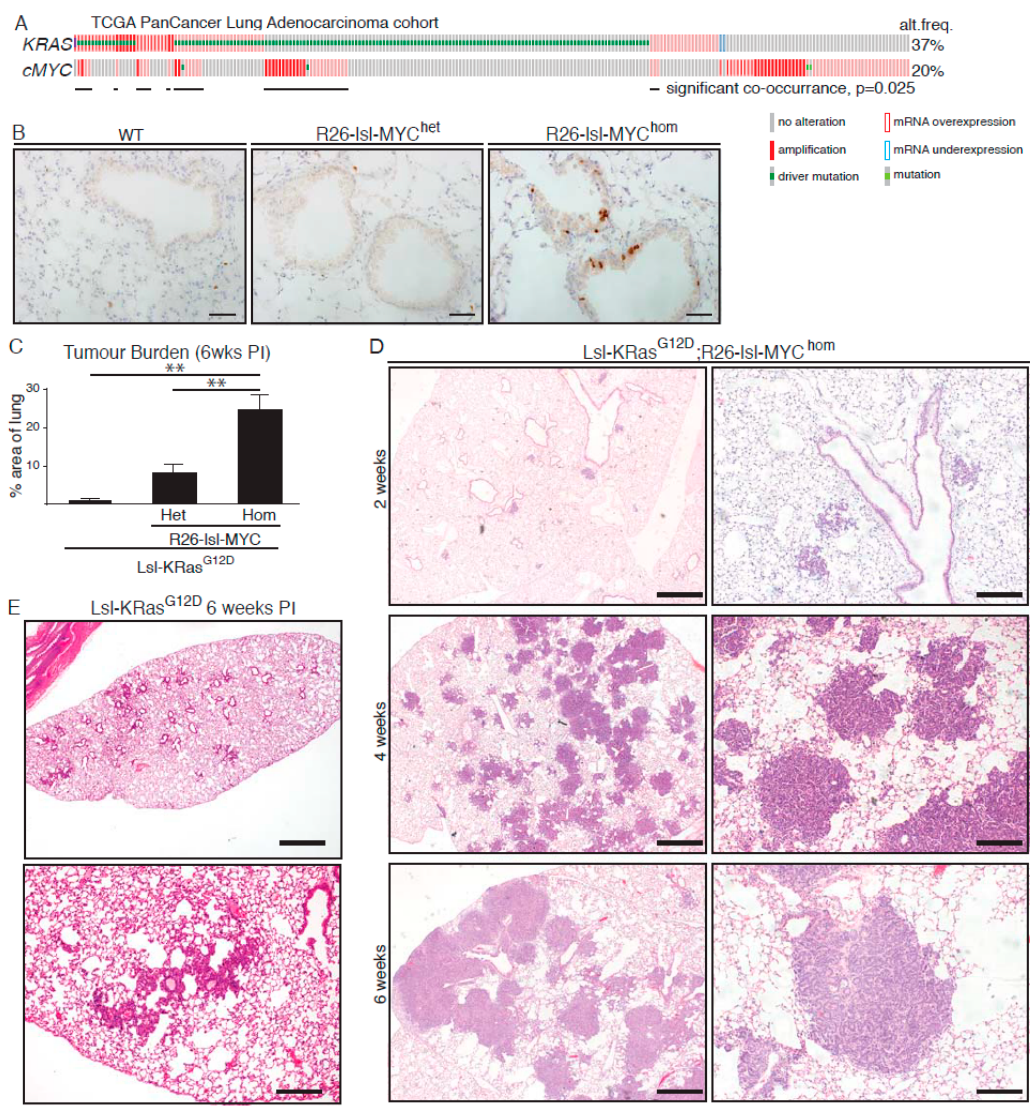
Figure 1. MYC accelerates KRas G12D -driven lung adenocarcinoma (LuAd) development. ( A ) Frequency of mutation, copy number, and mRNA expression alteration of KRAS and cMYC in the TCGA pan cancer lung adenocarcinoma cohort, accessed through cBioportal. For mRNA analysis, Z score threshold was set to 1.5. Horizontal black lines indicate cases with alteration of both KRAS and MYC. ( B ) Ectopic proliferation induced by CRE-dependent activation of Rosa26-lsl-MYC in airway epithelium evidenced by BrdU incorporation. Images are representative of at least 4 mice / genotype. Scale bar = 40 µ m. ( C ) Overall tumour burden, defined as the percent of lung area occupied by tumour tissue, in mice bearing 1 ( N = 9) or 2 ( N = 11) R26-lsl-MYC combined with lsl-KRas G12D , compared with lsl-KRas G12D alone ( N = 6), measured 6 weeks post induction (PI). Mean ± SEM shown. ** denotes p < 0.01 ( t -Test). ( D ) Adult mice (8–10weeks old) bearing the indicated conditional alleles were administered 1 × 10 7 pfu Adeno-CRE by intranasal installation and harvested at the indicated times PI. Micrographs show representative Hematoxylin and Eosin (H&E)-stained lung tissue. Scale bars = 1mm (left panels) and 200 μ m (right panels). ( E ) Age-matched lsl-KRas G12D mice were induced with the same pfu Adeno-CRE as (D) and tumour burden examined after 6 weeks. Scale bars = 1mm (top panel) and 200 μ m (bottom panel). Table 1. Specific genes upregulated in pErk High KM tumour regions. Genes were selected based on evidence of overexpression and/or amplification in human non-small cell lung cancer (NSCLC). Range of RNA-SEQ read count values, normalised for total reads per sample, for the indicated genes. FC = fold change. FDR = false discovery rate. Amp = Amplified. OverEx = Overexpressed. For “Amplified in human NSCLC”: Y = yes (1–5%) with >5% and <1% where noted; N = No; SCC = squamous cell carcinoma where noted, otherwise adenocarcinoma or unclassified. For “Overexpressed in human NSCLC”: Y = Yes; N = No.